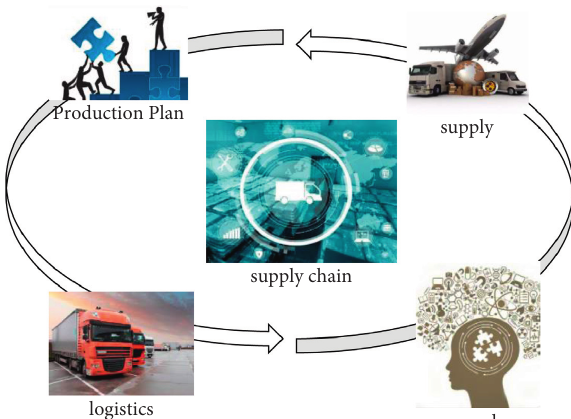
Figure 2: Fields involved in the supply chain.